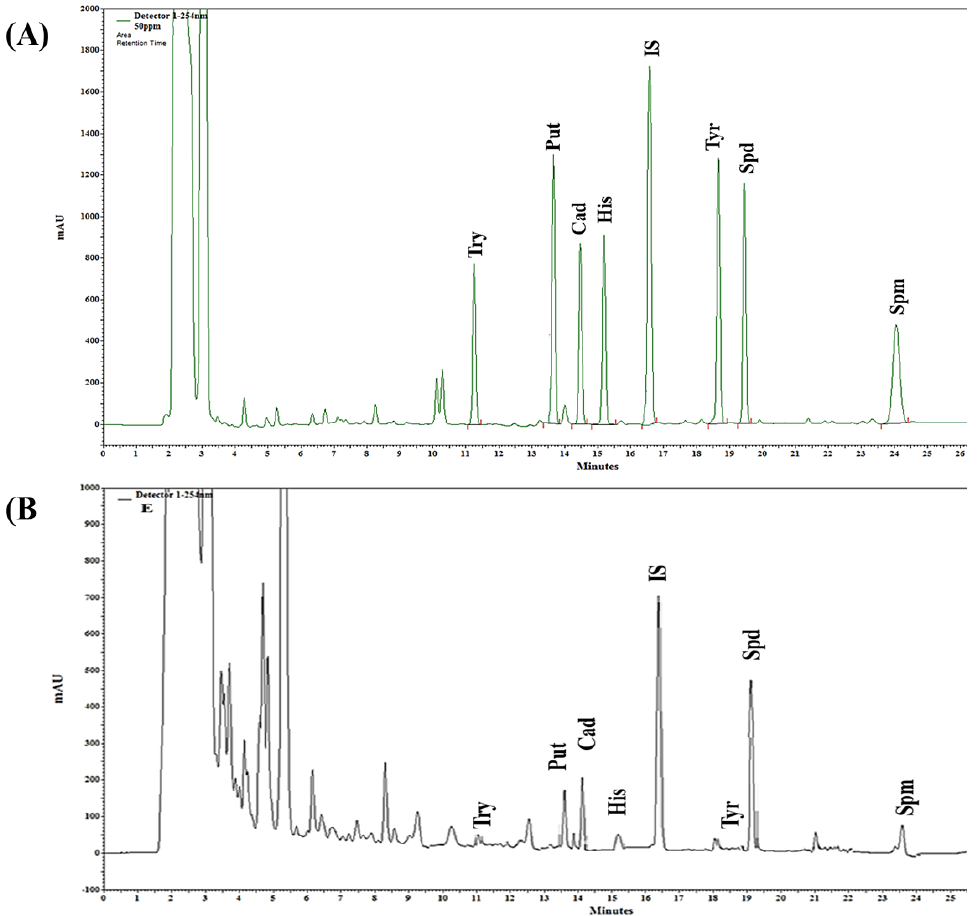
Figure 2. Representative HPLC chromatograms of all analyzed biogenic amines at λ = 254 nm. ( A ) Chromatogram of the standard mixture. ( B ) Representative chromatogram of one of the samples (ethanol extract). Try, tryptamine; Put, putrescine; Cad, cadaverine; His, histamine; IS (internal standard); Tyr, tyramine; Spd, spermidine; Spm, spermine.